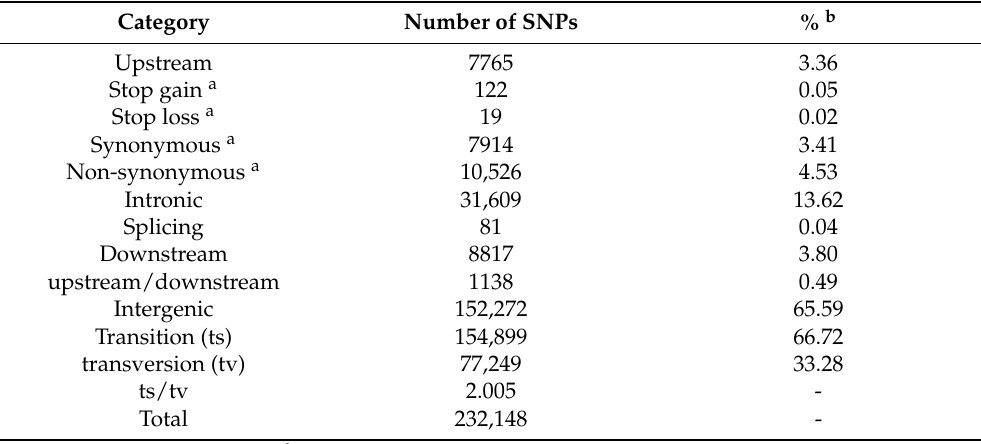
Table 2. SNPs detected and their characteristics among the 32 durian